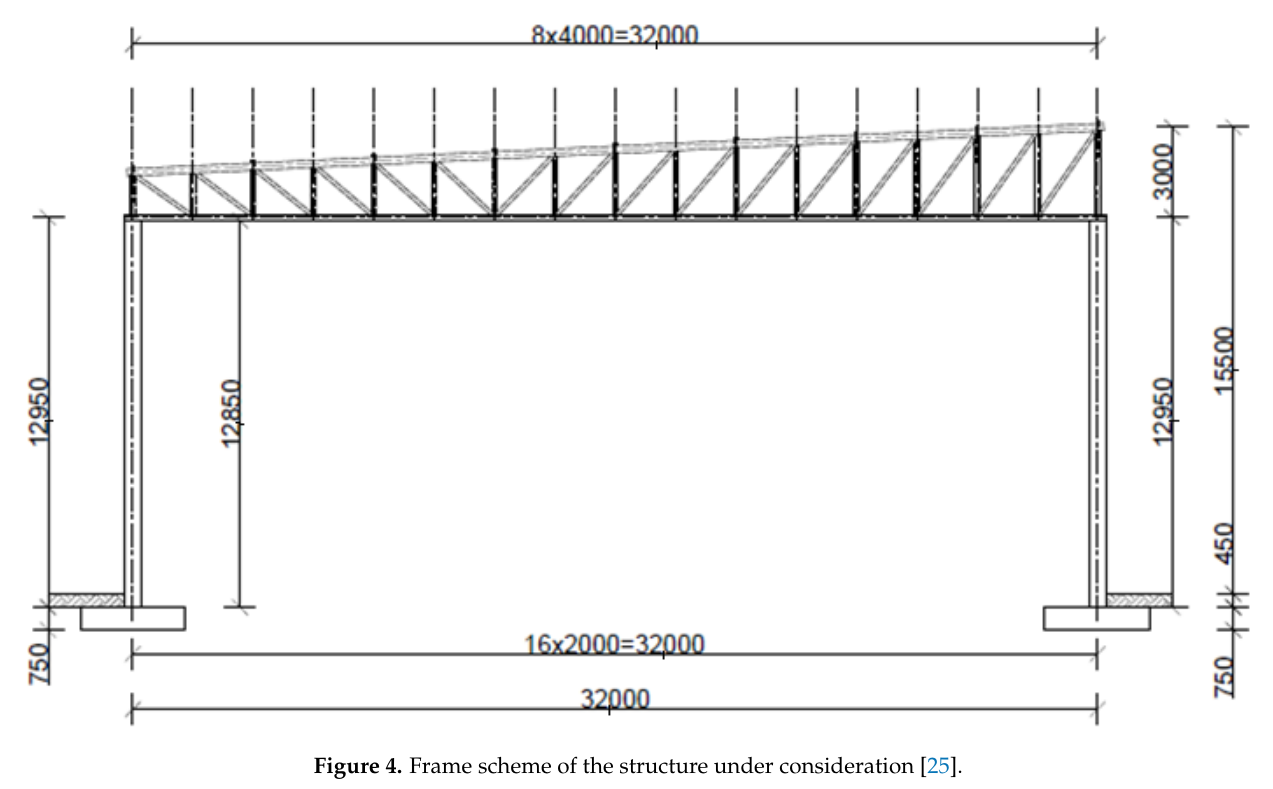
Figure 3. Spatial view of the analyzed structure [25].